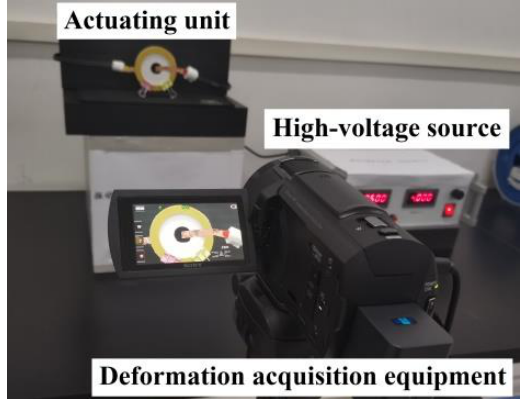
Figure 4. Electrostrain experimental platform.